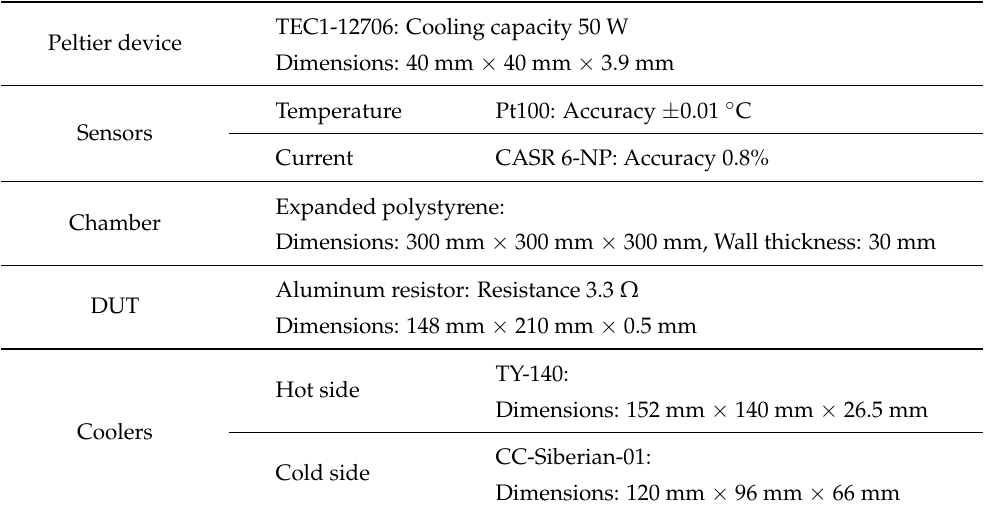
Table 5. Materials used for calorimetric system [5].